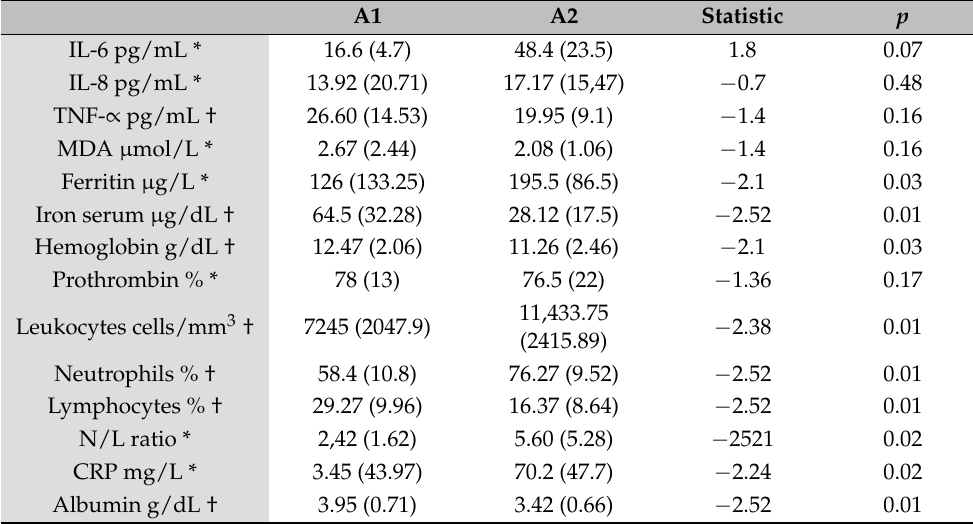
Statistic: (*) interquartile range and Z; (†) standard deviation and t. However, when we compared the same parameters between both groups 24 h after surgery (A2), we found significantly higher values in the OC group than in the LC group